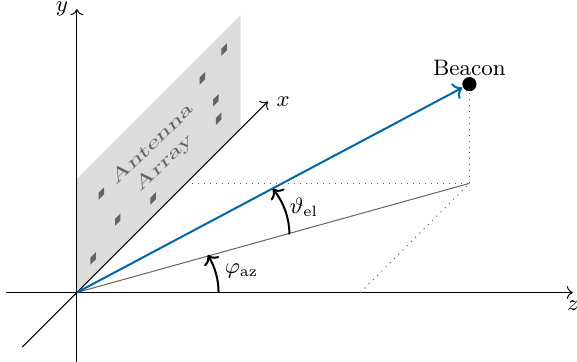
Figure 4. Definition of the azimuth and elevation angles in the antenna array coordinate